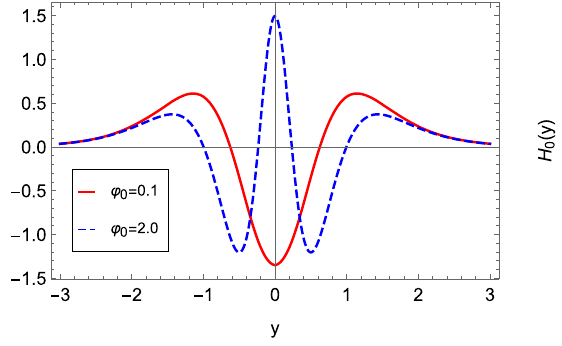
Fig. 10 Potential u ( y ) (left panel) and graviton zero mode H 0 ( y ) (right panel) for the solutions described in Sect. 3.4 with A 0 = 1, ψ = − 2 , and k = 1. Depending on the choice of ϕ 0 , the potential 0 3